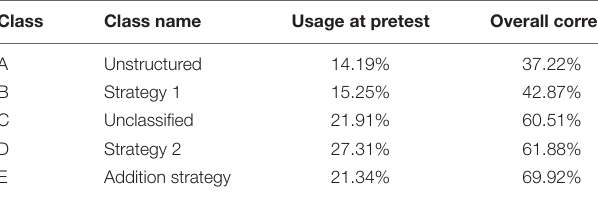
TABLE 4 | Classes, their names, usage, and overall correct at